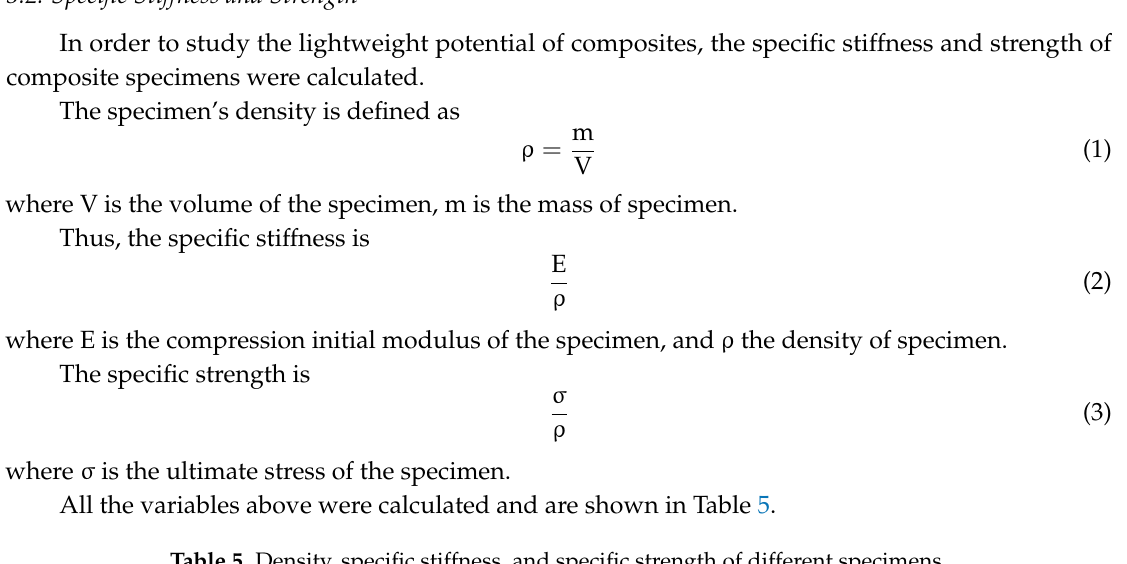
Table 5. Density, specific stiffness, and specific strength of different